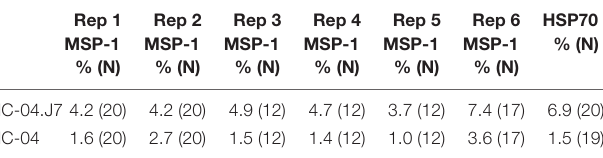
TABLE 2 | Exoerythrocytic form development is supported following sporozoite